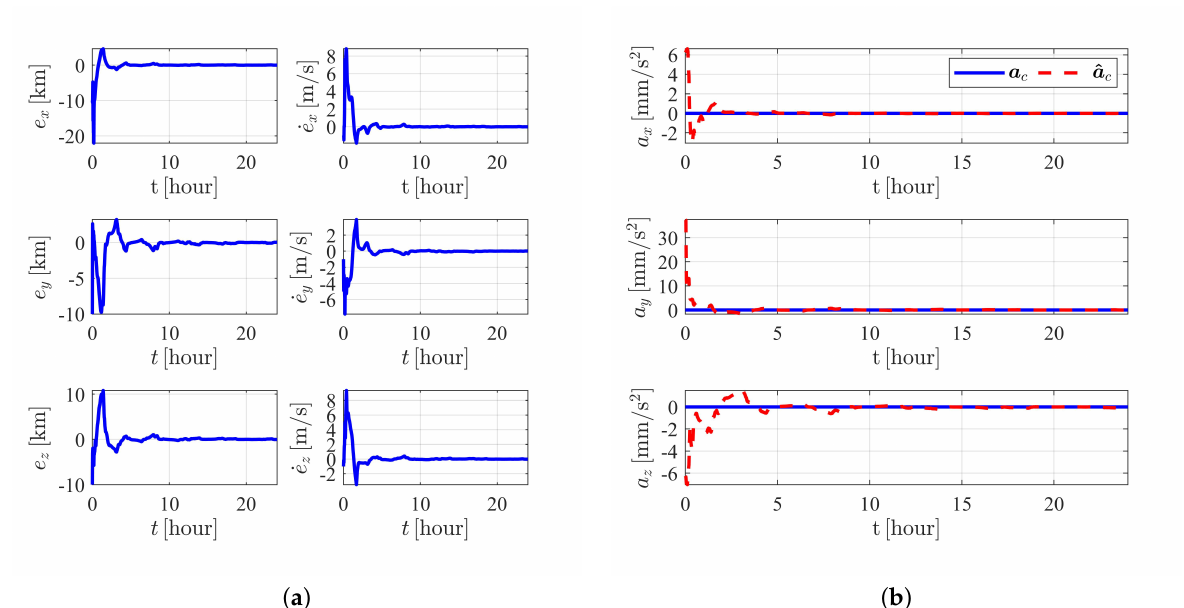
Figure 13. OD results of the non-maneuvering case. ( a ) State estimated errors. ( b ) Maneuver estimated comparison (the blue lines denote the real maneuvering acceleration and the red dashed lines represent the estimated maneuvering acceleration).